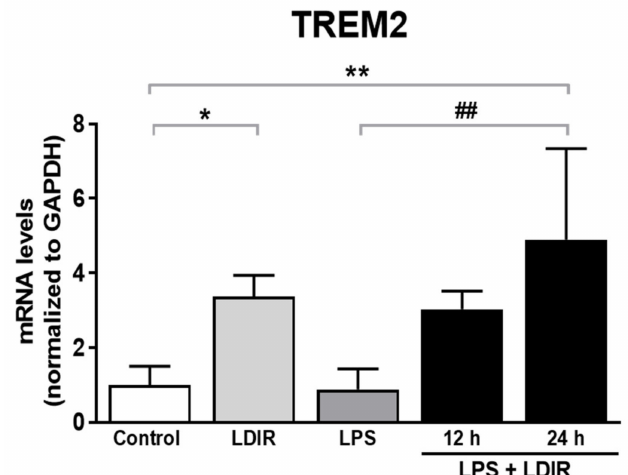
Figure 5. The enhancing e ff ects of LDIR exposure on expression of TREM2 in LPS-stimulated BV-2 cells. BV-2 cells were treated with LPS at a dose of 20 ng / mL for 24 h, and then were exposed to LDIR (1 Gy / 1 fraction). Cells were harvested at 12 and 24 h after irradiation. After irradiation and / or LPS treatment, levels of TREM2 mRNA were detected by qRT-PCR in BV-2 cells. * p < 0.05, ** p < 0.01 indicate significant di ff erences to control group. ## p < 0.01 indicate significant di ff erences to LPS group. Data are presented as mean ± SD from triplicate